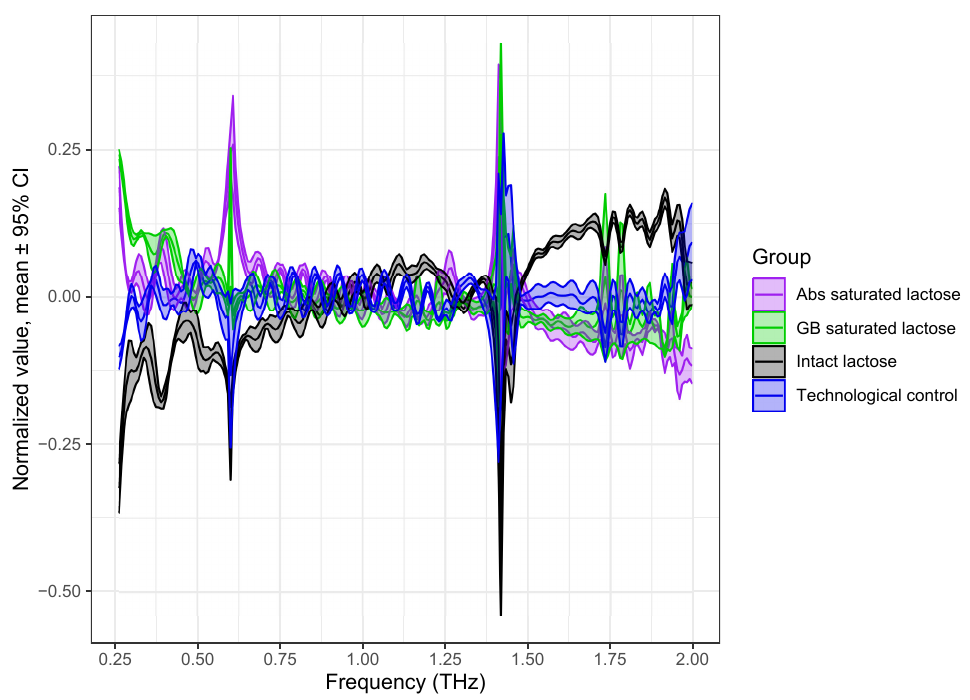
Figure 4. Scaled THz absorption spectra of lactose with different formulations preprocessed by normalization to SNV and mean centering of data. Spectra are presented as mean line with 95% confidence interval